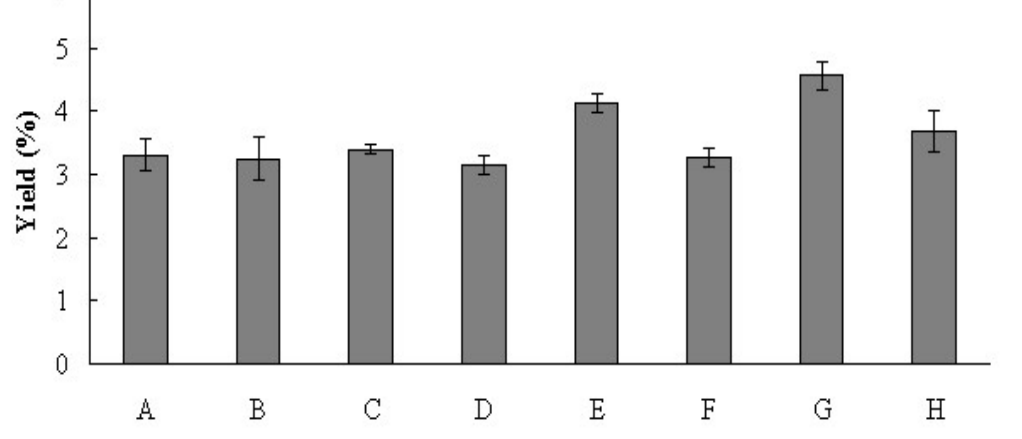
Figure 1. Essential oil yields of Litsea cubeba harvested from different